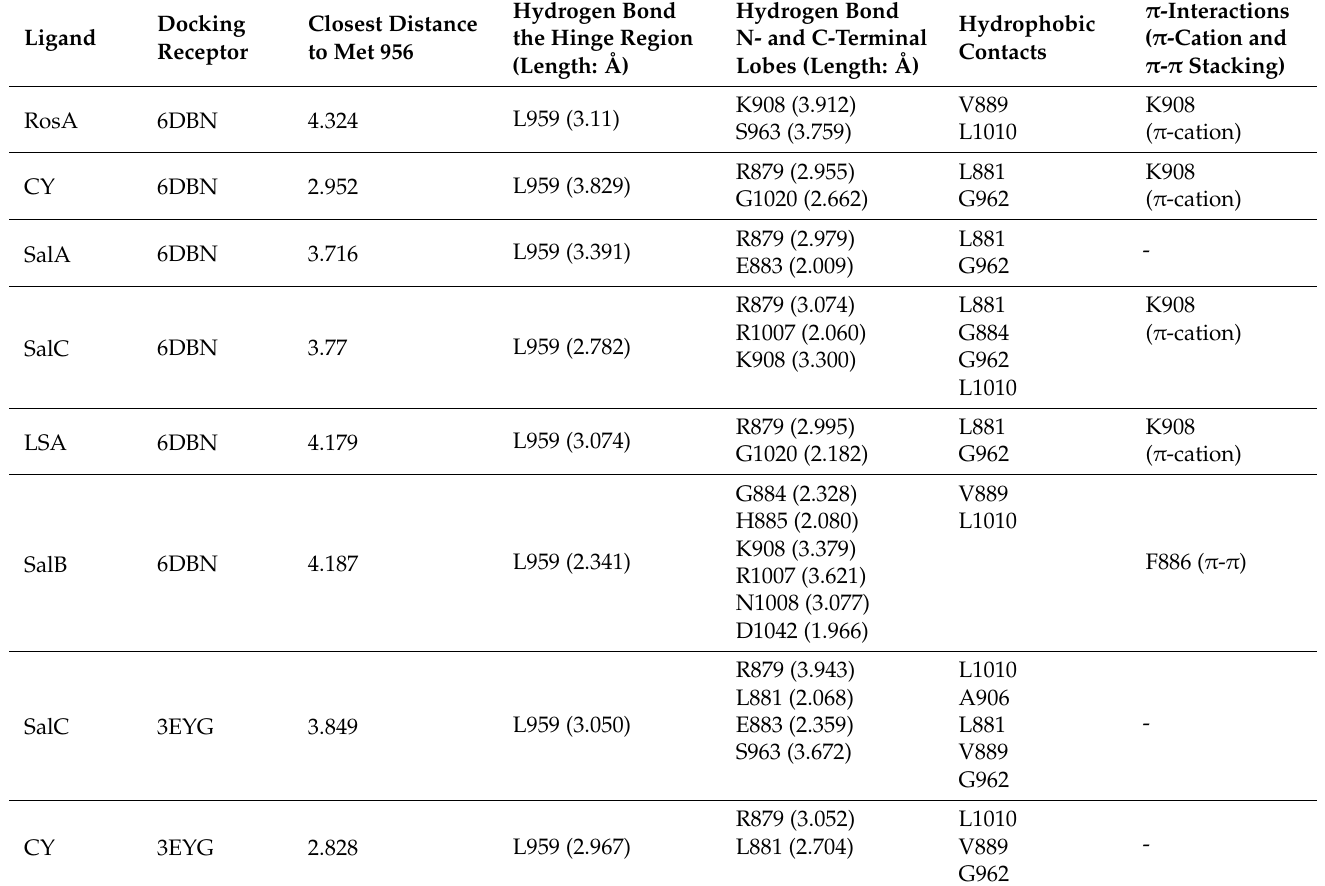
Table 2. Receptor–ligand interaction of six phenolic acids docking with